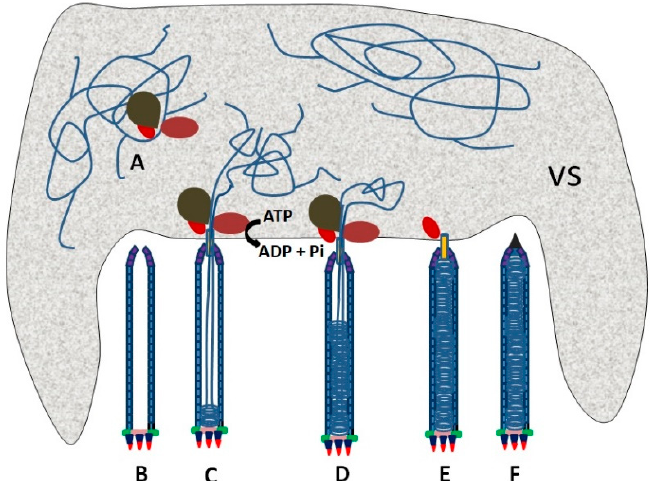
Figure 2. Theoretical schematic of the genome packaging in a baculovirus. ( A ) A cis -acting element is recognized by a packaging protein complex. ( B ) A preformed capsid is assembled and waits for docking of the viral genome onto it though the packaging complex. ( C , D ) The viral genome is packaged through a portal at the apical cap of the preformed capsid with the aid of ATP hydrolysis. ( E ) The packaging complex is released after a genome DNA with one unit length is packaged. ( F ) The portal of a capsid is blocked with structure protein(s) to form mature nucleocapsid. The shaded area is the virogenic stroma